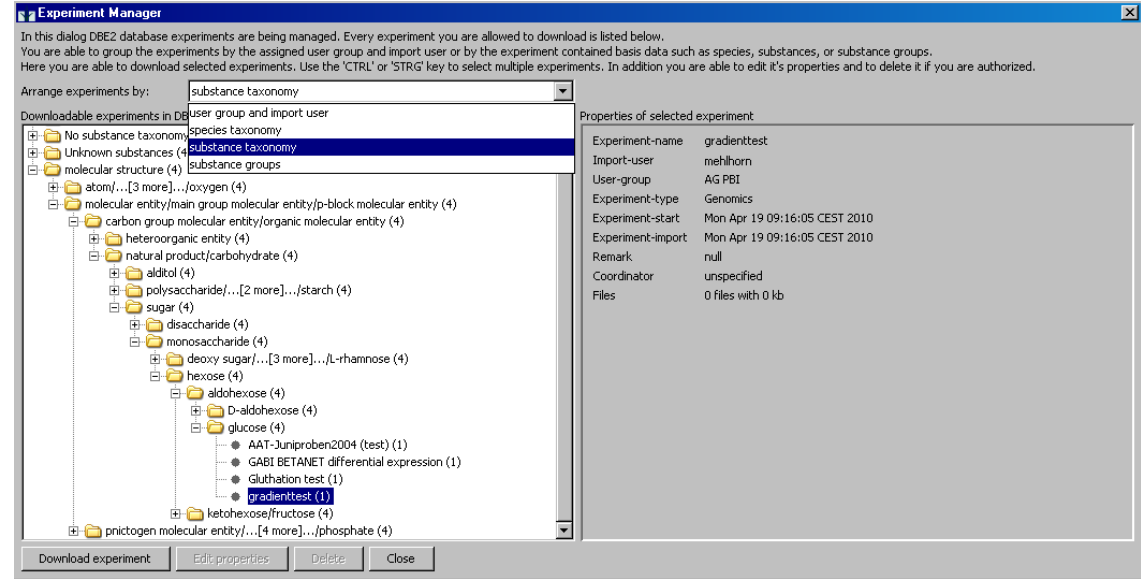
Figure 5: The Experiment manager dialog of the DBE2 client . The user is able to arrange the accessible experiment s in four ways. The (i) user group arrangement helps to survey user rights to experiment s. The (ii) substance taxonomy arrangement (shown), the (iii) species taxonomy ar- rangement, and the (iv) substance group arrangement enable an experiment overview according to the annotation